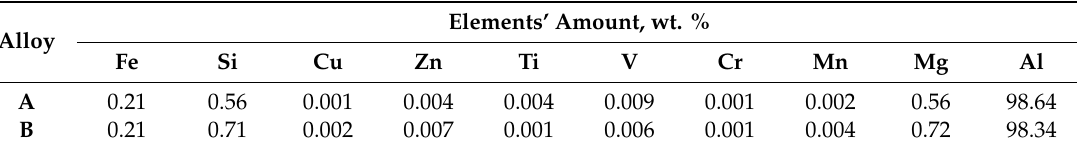
Table 1. Chemical composition of the Al-Mg-Si wire rod.